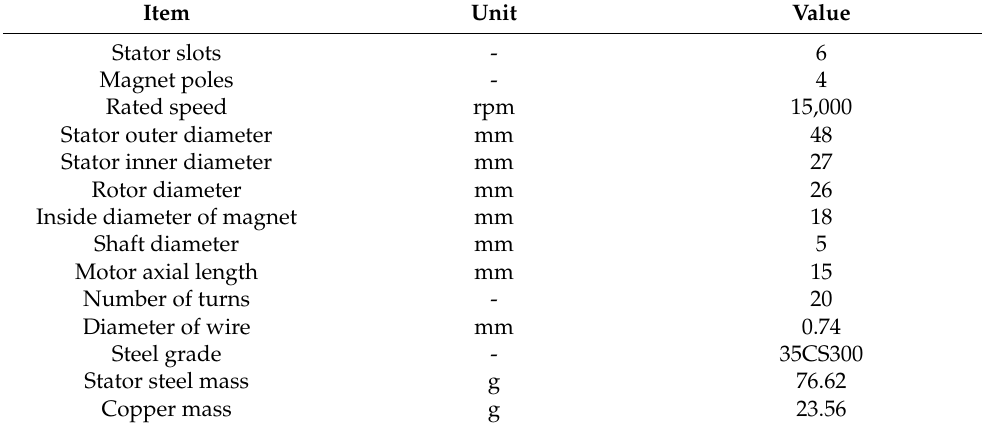
Table 1. Specifications of the motor.